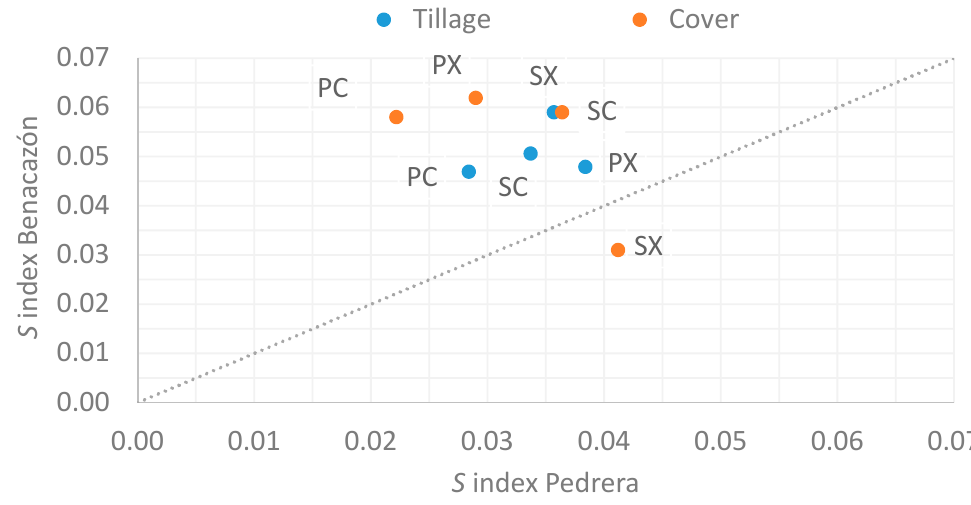
Figure 2. Comparison between the S index at Pedrera (X axis) and Benacazón (Y axis) obtained with the mean WRC from the van Genutchen equation. Blue and orange dots show Tillage and Cover managements, respectively, at the different areas: SX (0–10 cm inter tree row), PX (10–20 cm inter tree row), SC (0–10 cm under tree canopies) and PC (10–20 cm under tree canopies).